Question: What does this figure show? Answer in one sentence.
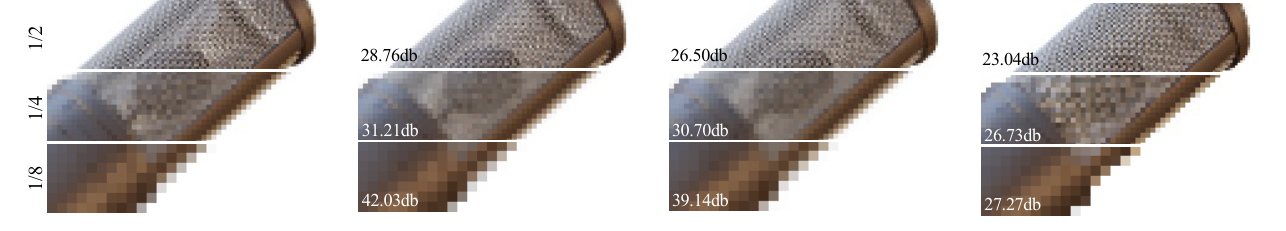
Answer: Qualitative comparison of the multi-resolution evaluation on the mic scene from the multi-scale Blender dataset. PSNR values are shown in the bottom right corners of each result.